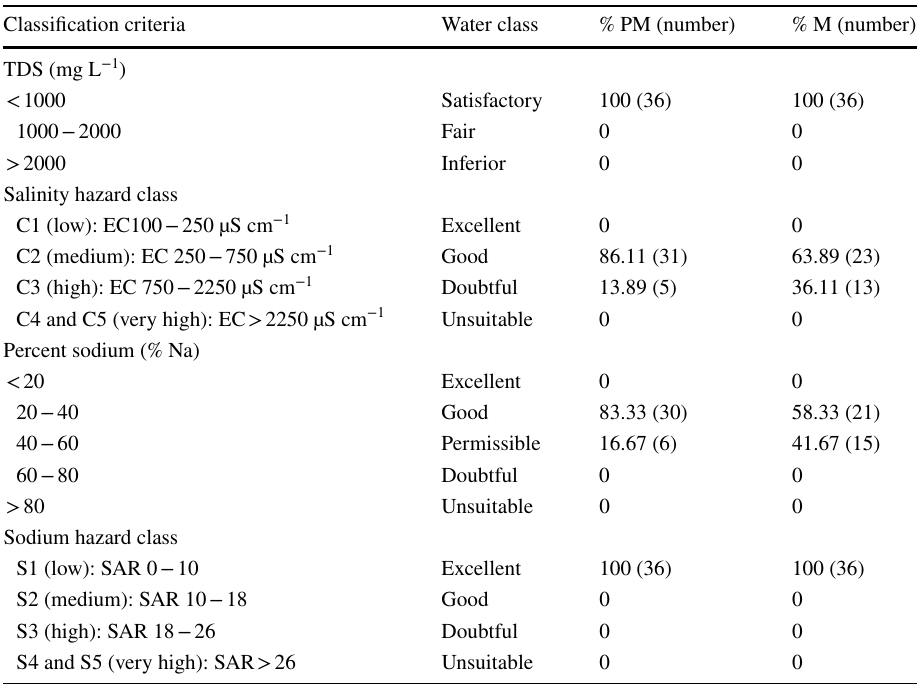
characteristics in Ballia district, Uttar Pradesh, on the basis of TDS, EC, percent sodium (% Na) and sodium absorption ratio (SAR) for agricultural irrigation